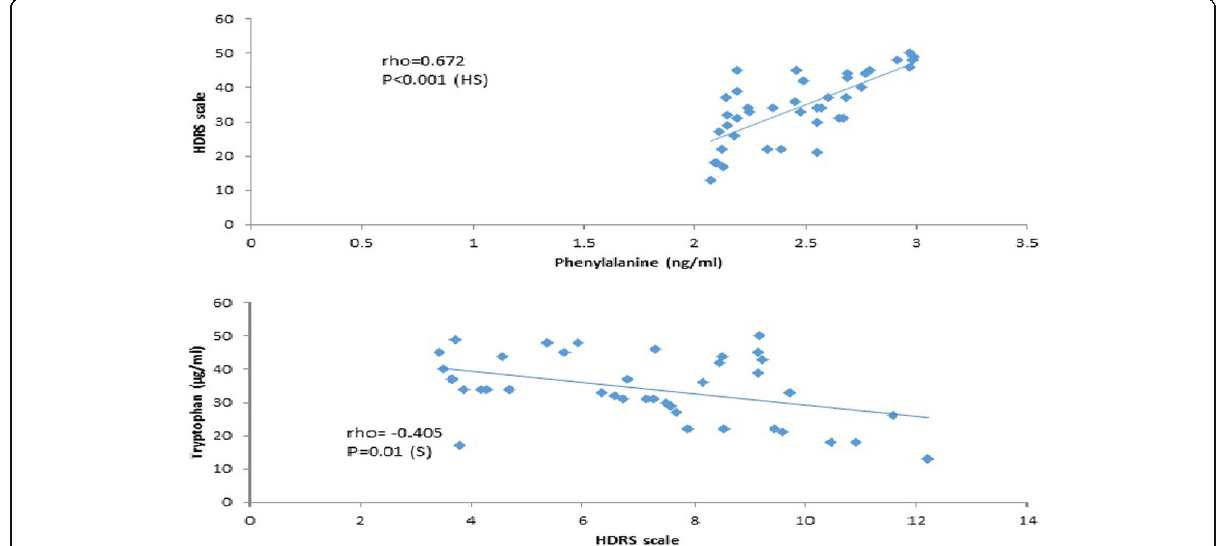
Fig. 2 ROC curve for the performance of phenylalanine ( a ) and tryptophan ( b ) in the prediction of very severe depression among the treated